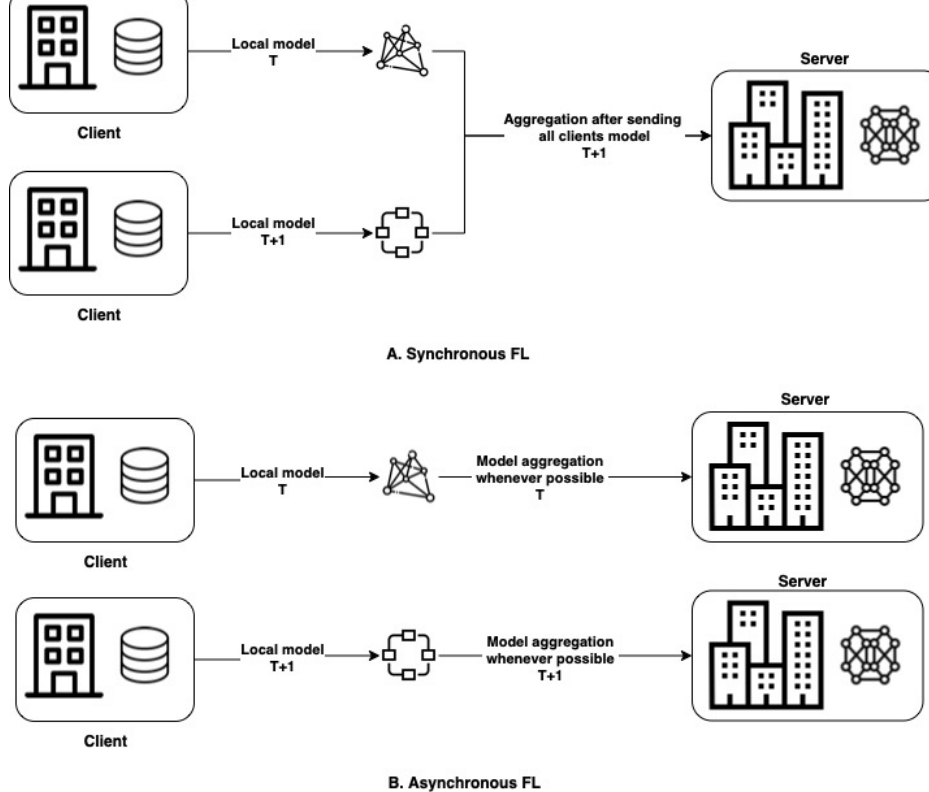
Figure 5. Synchronous and asynchronous FL